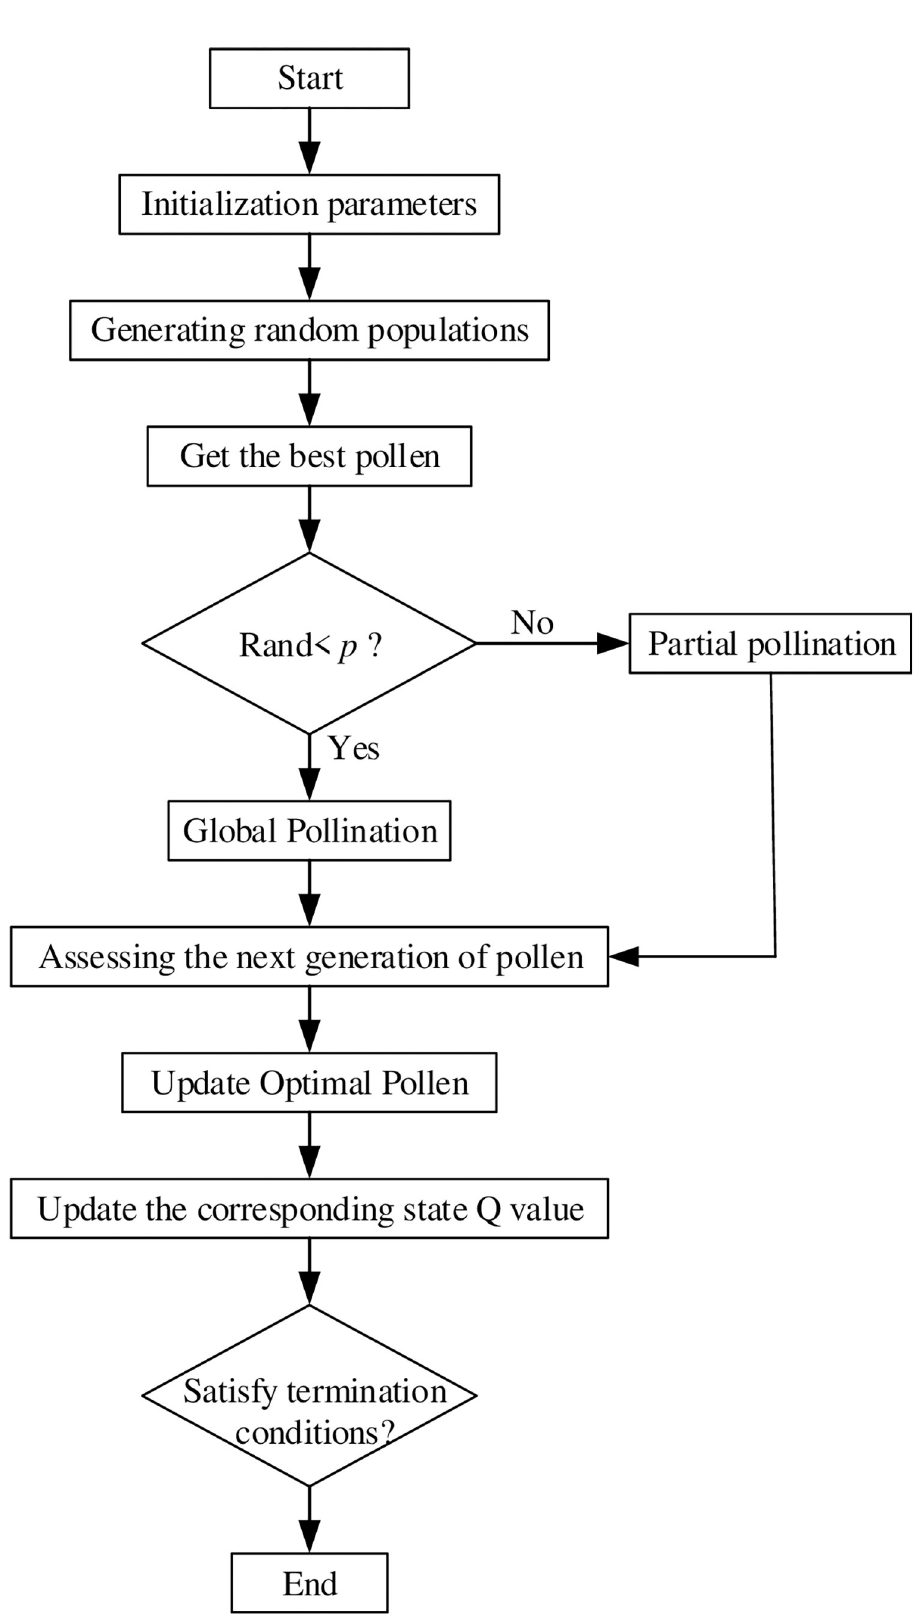
Fig 5. Initialize Q-table with